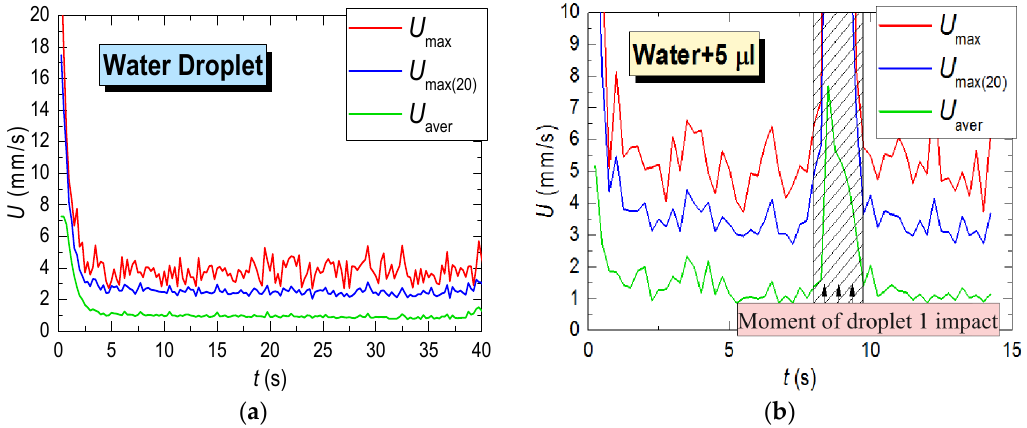
Figure 2. ( a ) Change of characteristic velocities U max , U max(20) , and U aver in the horizontal section of the water drop 2 ( V 02 = 40 μ l; T w = 80 °C); ( b ) change of characteristic velocities U max , U max(20) , and U aver in the horizontal section of sessile drop 2 at droplet 1 falling ( V 02 = 40 μ l; V 01 = 2.5 μ l; T W = 80 °C).